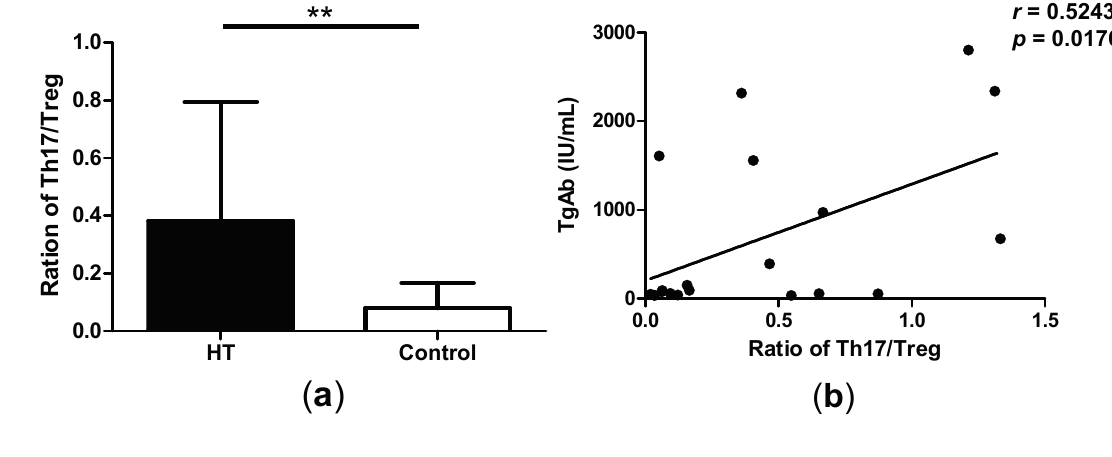
Figure 3. Correlation between Th17/Treg balance and TgAb levels in HT patients. ( a ) The ratio of Th17/Treg in patients with HT compared with healthy controls and ( b ) The correlation between the ratio of Th17/Treg and TgAb levels in HT patients. ** p <